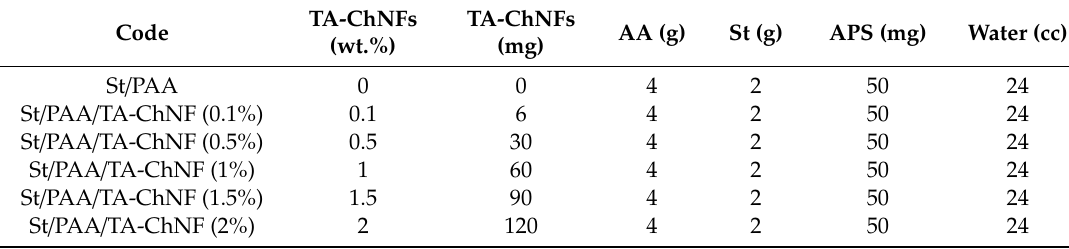
Table 1. Compositions of the